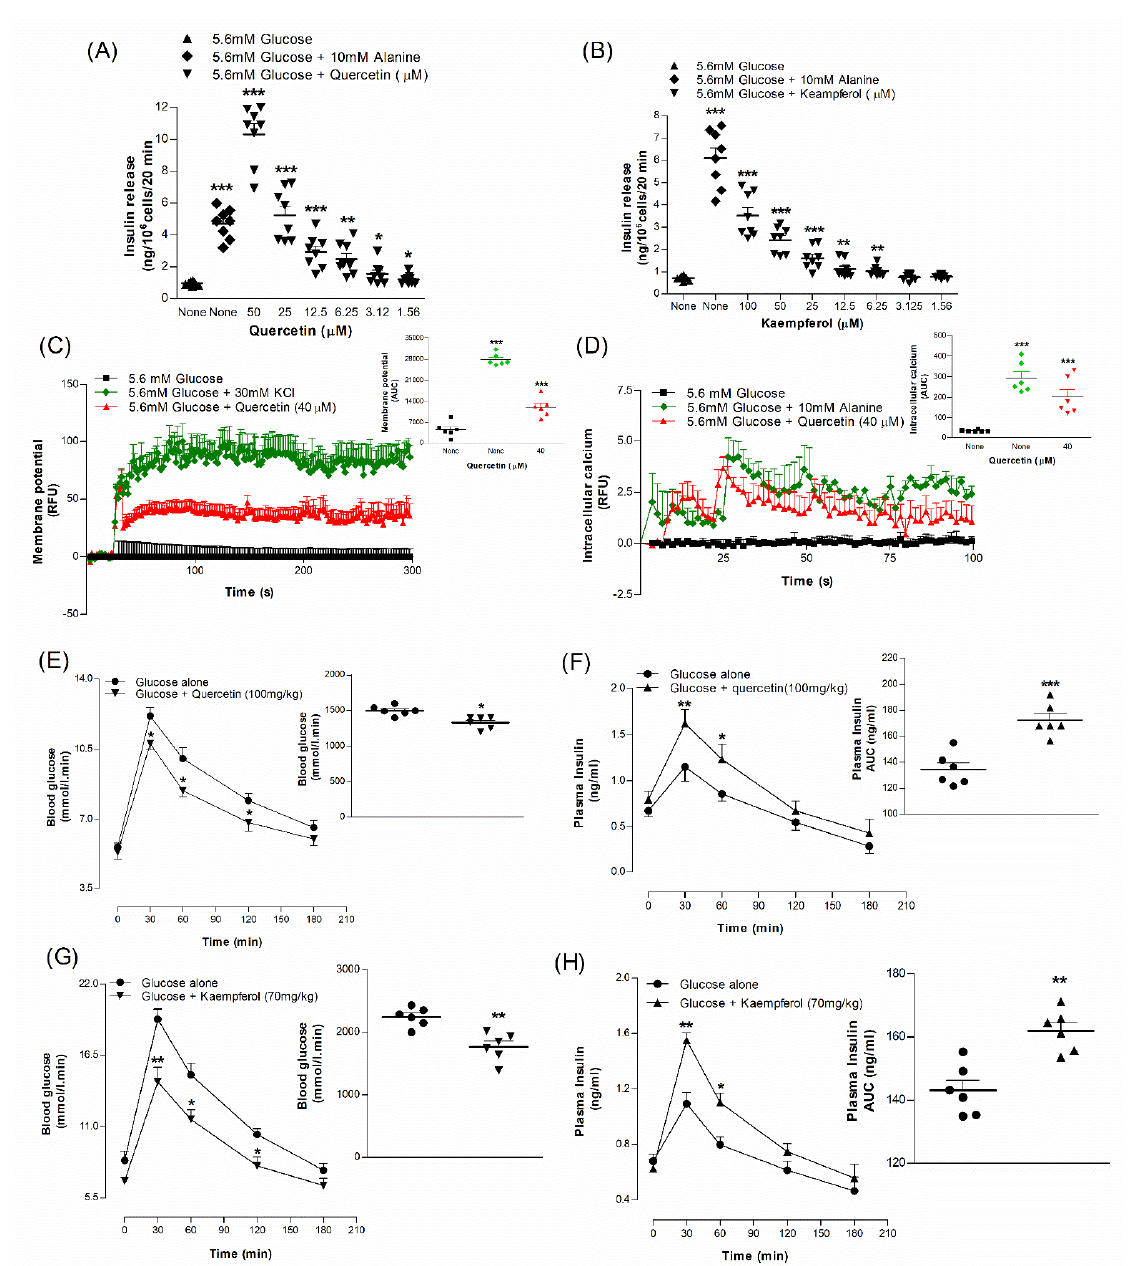
Figure 9. Insulin-releasing effects of ( A ) Quercetin and ( B ) Kaempferol, ( C ) membrane potential and ( D ) intracellular calcium from BRIN-BD11 cells, ( E , G ) glucose tolerance and ( F , H ) plasma insulin. Mice were fasted for 12 h and administered glucose (18 mmol/kg body weight) by oral gavage with or without ( E , F ) simultaneous quercetin (100 mg/kg b.w.) and ( G , H ) kaempferol (70 mg/kg b.w.). Values are the mean ± SEM for n = 8 for insulin release, n = 6 for membrane potential, intracellular calcium, glucose tolerance and plasma insulin. * p < 0.05, ** p < 0.01 and *** p < 0.001 compared to